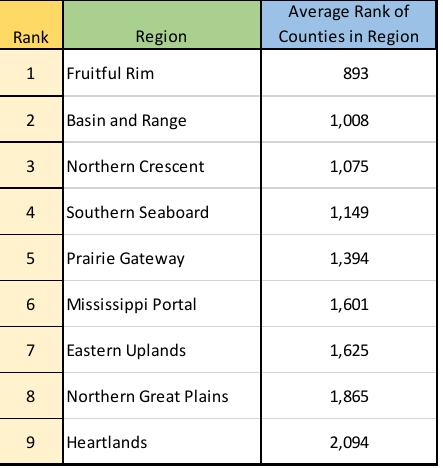
Table 9. Region Ranking, Organic Sales,